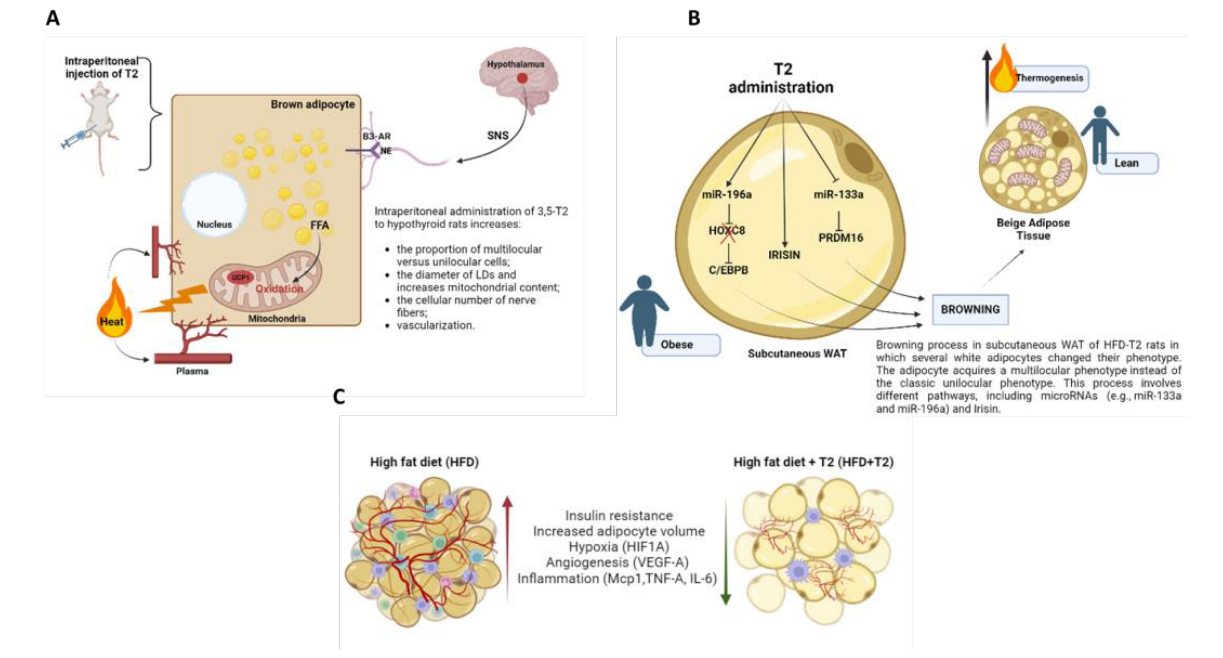
Figure 3. ( A ) In hypothyroid rats housed at thermoneutrality, 3,5-T2 increases multilocular versus unilocular cells, decreases LD diameter, and increases mitochondrial content, indicating BAT ac- tivation. Diiodothyronine also increases the cellular number of nerve fibers and vascularization, suggesting that part of the thermogenic effect induced by 3,5-T2 in BAT is due to SNS activation. ( B ) Browning process in a section of anterior sWAT of HFD-T2 rats in which several white adipocytes undergo phenotypic change. The adipocyte acquires a multilocular phenotype as an alternative to the conventional unilocular phenotype, with high levels of UCP1. This process involves different pathways, including microRNAs (e.g., miR-133a and miR-196a) and irisin. ( C ) Schematic representa- tion of the effects exerted on adipocytes in vWAT by HFD for 14 weeks and by HFD for 14 weeks and 3,5-T2 administered daily during the last 4 weeks (HFD-T2). In vWAT from overweight rats, hypoxia induces the synthesis of several angiogenic factors (e.g., VEGF-A) and the expression of inflammatory cytokines (e.g., TNF-α, IL-6). Accordingly, a vicious circle is established in which the activation of angiogenesis first determines a further increase in adipocyte volume, thus enhancing an increase in the inflammatory state of the AT. In overweight rats treated with 3,5-T2, the inflam- matory state is reverted. Diiodothyronine can reduce hypoxia, angiogenesis, and inflammatory agents. The figure was created with Biorender.com.